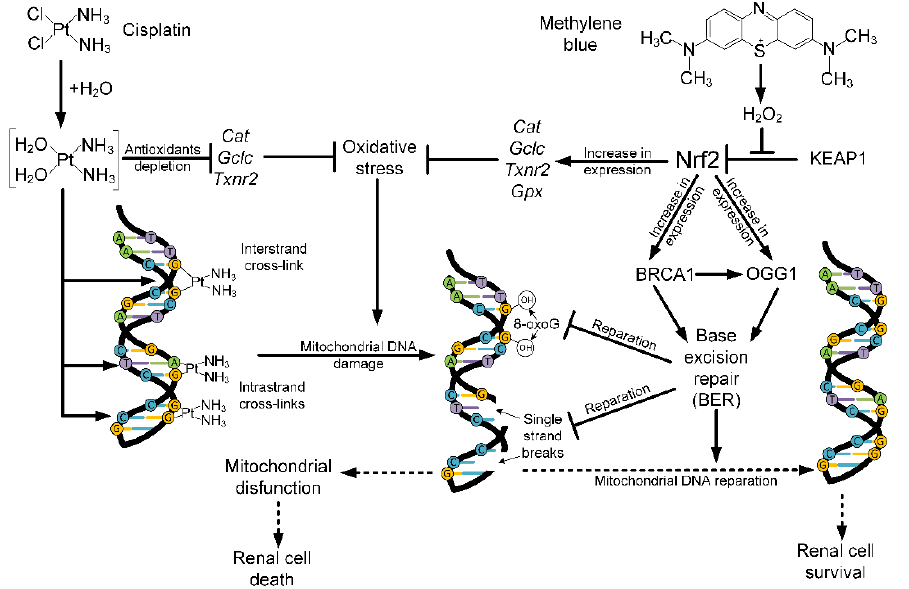
Figure 6. Effect of cisplatin and methylene blue on the oxidative stress and mtDNA damage. Cis- platin penetrates the cell in the aquatic form. Chloride atoms on cisplatin are displaced by water molecules. Cisplatin can cause antioxidant depletion and mtDNA damage by origins of interstrand and intrastrand crosslinks, with subsequent formation of oxidized guanine bases and single-strand breaks. Damage of the mtDNA can cause mitochondrial dysfunction and renal cell death. Methylene blue induces H 2 O 2 production in mitochondria. H 2 O 2 can trigger the Nrf2/ARE signaling pathway by oxidation of Keap1. Nrf2 can increase the expression of antioxidant genes for defense against cisplatin-induced oxidative stress. Nrf2 activation leads to increase the expression of genes which are involved in the base excision repair (BER): the main mechanism of mtDNA reparation. BER restores an intact mtDNA structure and protects kidney cells from